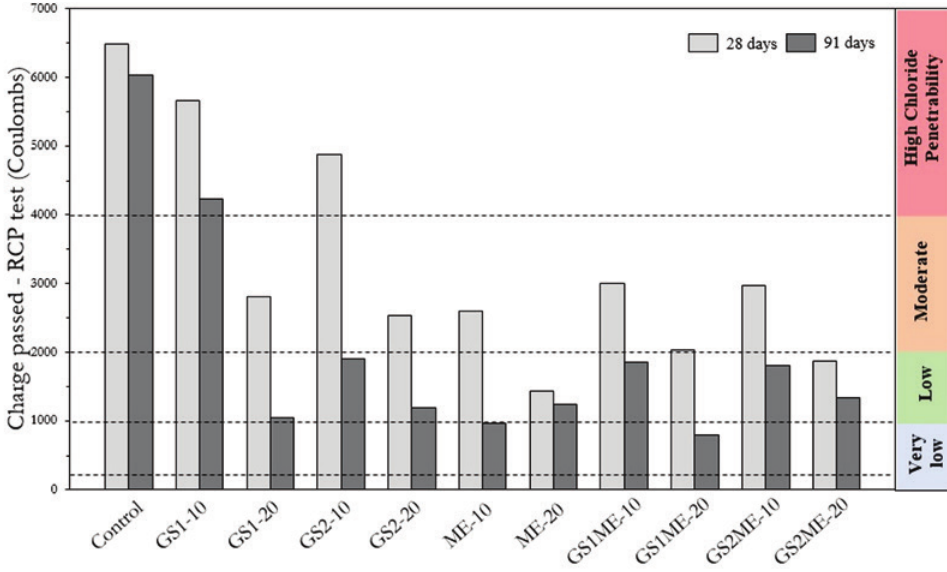
Total charge passed results and chloride resistance